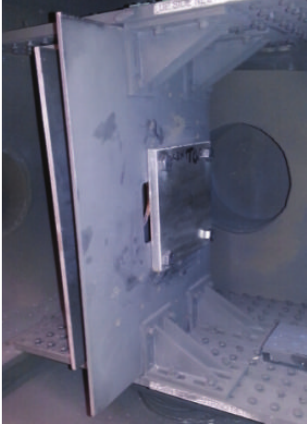
Figure 2: Target plate bolted inside the gas gun